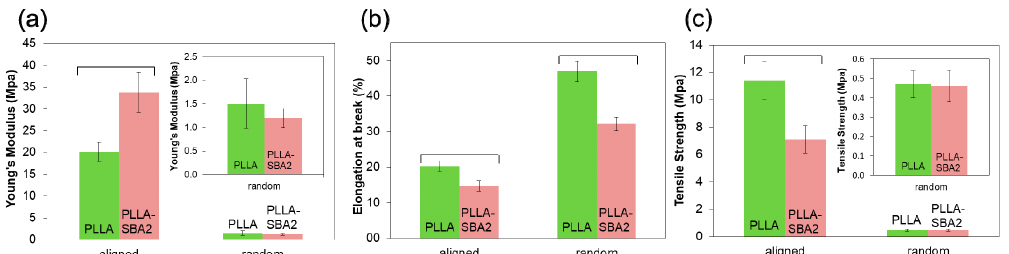
Figure 4. Young’s modulus ( a ), elongation at break ( b ) and tensile strength ( c ) of random and aligned fibres. Results are expressed as (mean ± standard deviation). Bars show statistically significant differences ( p < 0.05). In the inset of ( a ) and ( c ) a zoom view of the properties of randomly oriented fibres is reported.